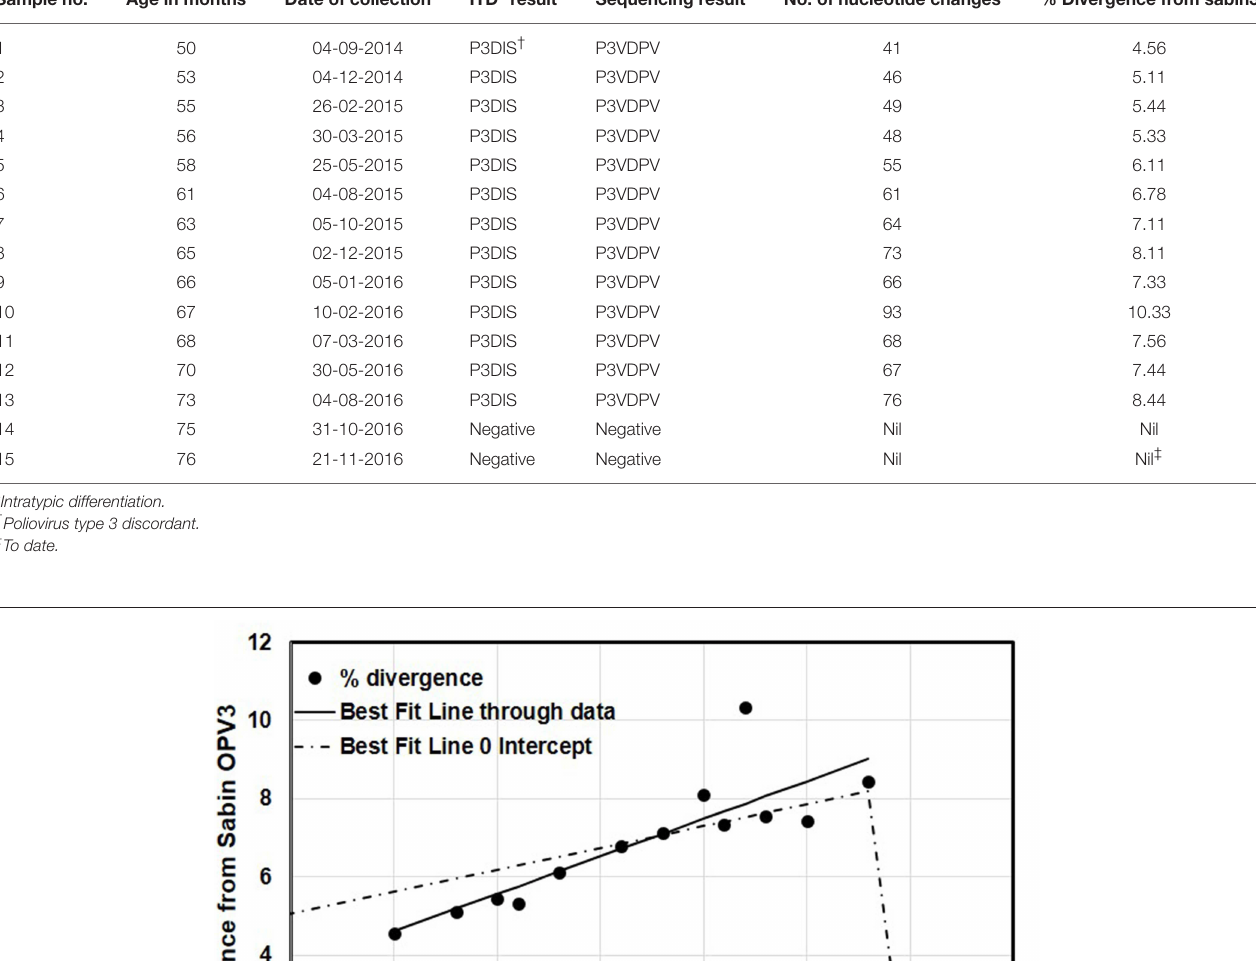
TABLE 2 | History of virus isolation from the SCID patient. Sample no.